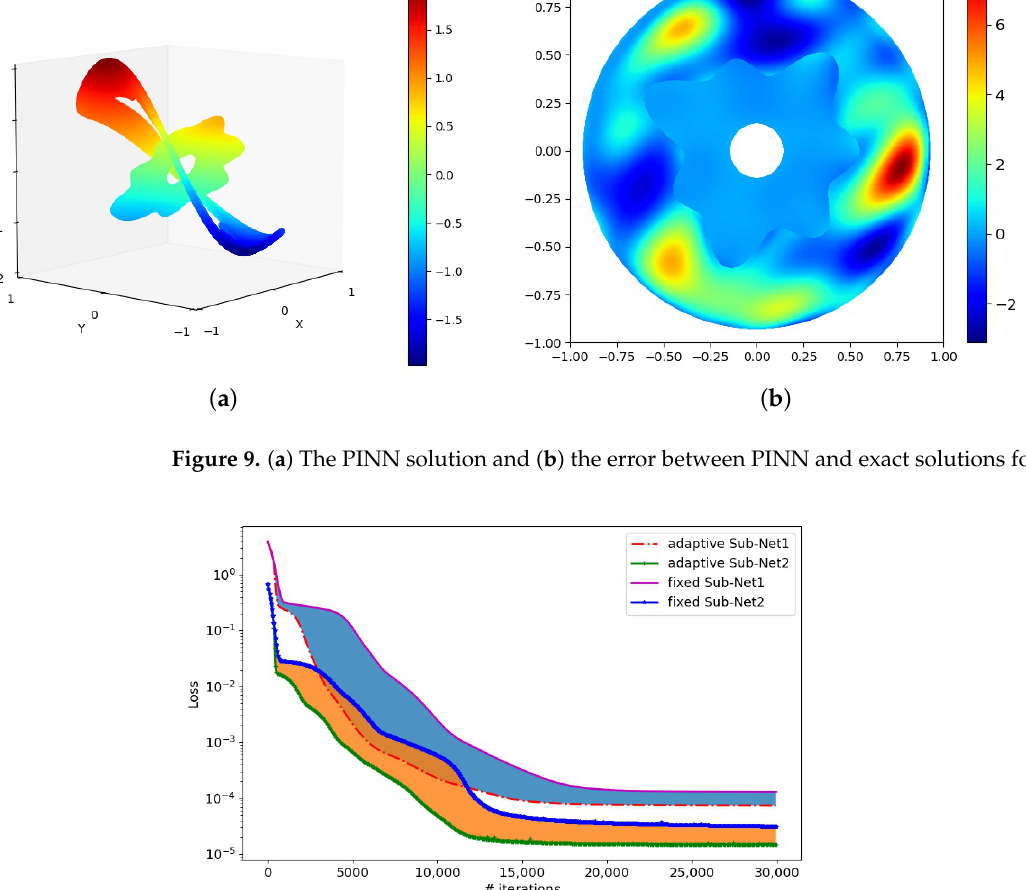
Figure 10. The evolution plot of loss L 2 error for Example